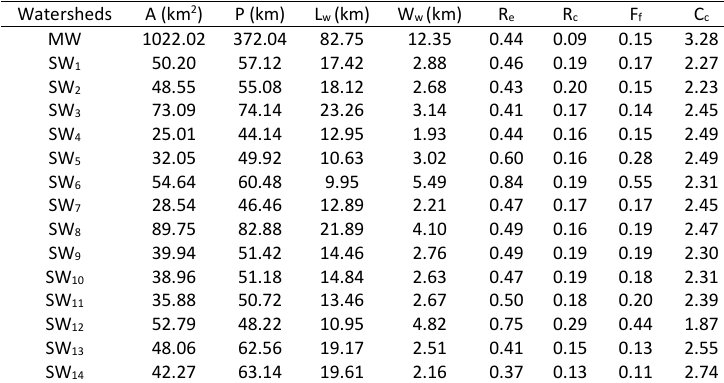
Table 3: Geomorphometric values for areal parameters Table 3. Geomorphometric values for areal